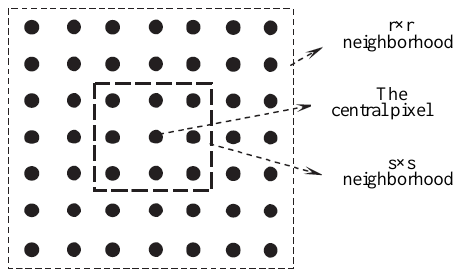
Figure 3. The neighborhood windows (Up: the large r × r neighborhood, Down: the small s × s neighborhood around the central